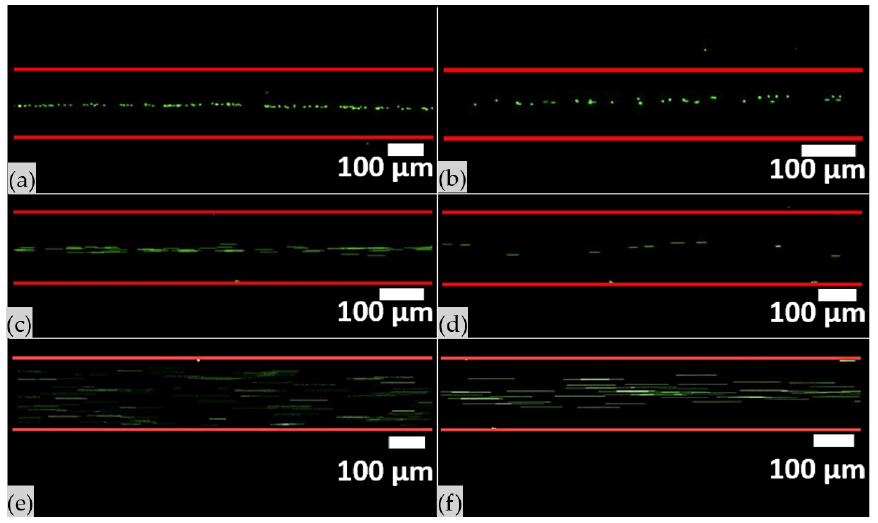
Figure 6. Frame of time lapse acquired during the acoustophoretic test, when 4MPs were employed at different concentrations and flow rates: ( a ) 4MPs concentrated at 5.68 × 10 6 particles/mL were injected at 1 µ L/min, ( b ) 4MPs concentrated at 1.41 × 10 6 particles/mL were injected at 1 µ L/min, ( c ) 4MPs concentrated at 5.68 × 10 6 particles/mL were injected at 3 µ L/min, ( d ) 4MPs concentrated at 1.41 × 10 6 particles/mL were injected at 3 µL/min, ( e ) 4MPs concentrated at 5.68 × 10 6 particles/mL were injected at 10 µL/min and ( f ) 4MPs concentrated at 1.41 × 10 6 particles/mL were injected at 10 µL/min. Experiments were performed by applying 50.59 Vpp at the transducer, while the device was actuated at its resonant frequency of 4.623 MHz. Images acquired with 4x objective lens with an exposure time of 9.8 ms.